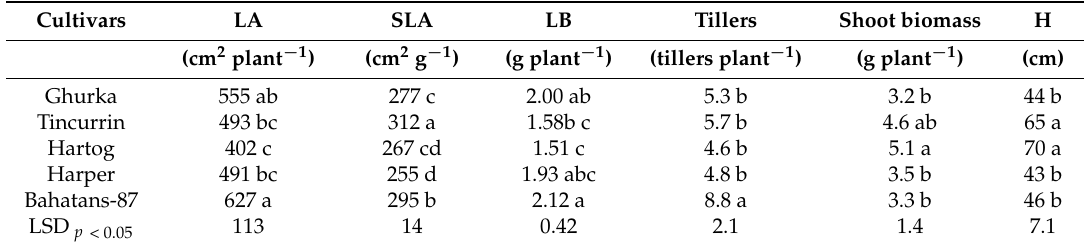
Table 3. Leaf area (LA), specific leaf area (SLA), leaf biomass (LB), tiller number , shoot biomass and plant height (H) of five wheat cultivars at harvest (63